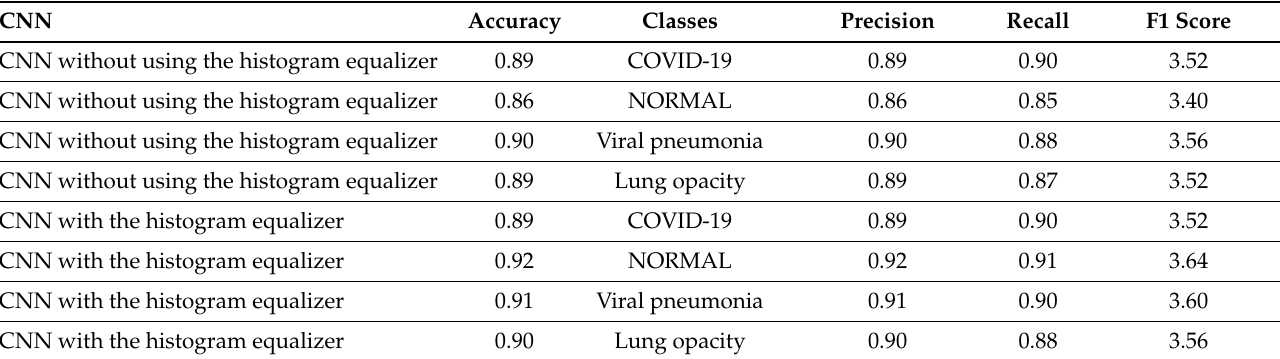
Table 4. Results of accuracy classification and algorithm evaluation for